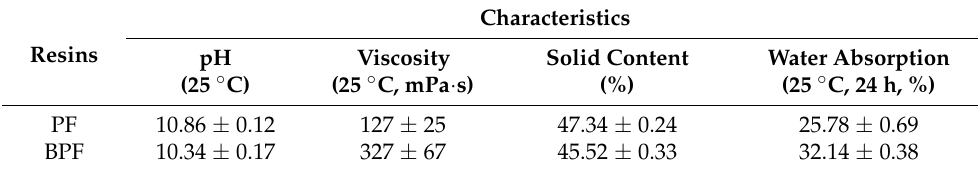
Table 1. Characteristics of BPF and